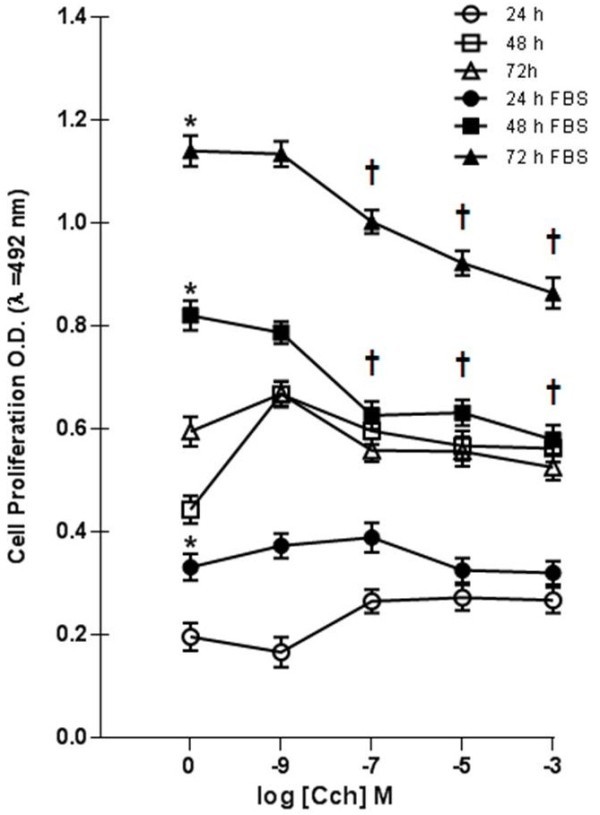
Rat ASMC proliferation response to muscarinic agonist Cch. ASMC (1 × 103 cells/well) were cultured in 96 wells plates at 37°C/5% CO2 with increasing concentration of muscarinic agonist Cch in medium without FBS during 24 (○), 48 (□), y 72 (∆), and 10% FBS, during 24 (●), 48 (■), y 72 (▲) hrs. Cell proliferation was determined using a colorimetric method (MTS-PMS), measuring O.D at λ = 492 nm. Data are the mean ± SE of n = 6 experiments for triplicate. Mitogen responses of 10% FBS vs. basal was significant (*) p < 0.05. The inhibitory effect of Cch was significant (┼) p < 0.05.